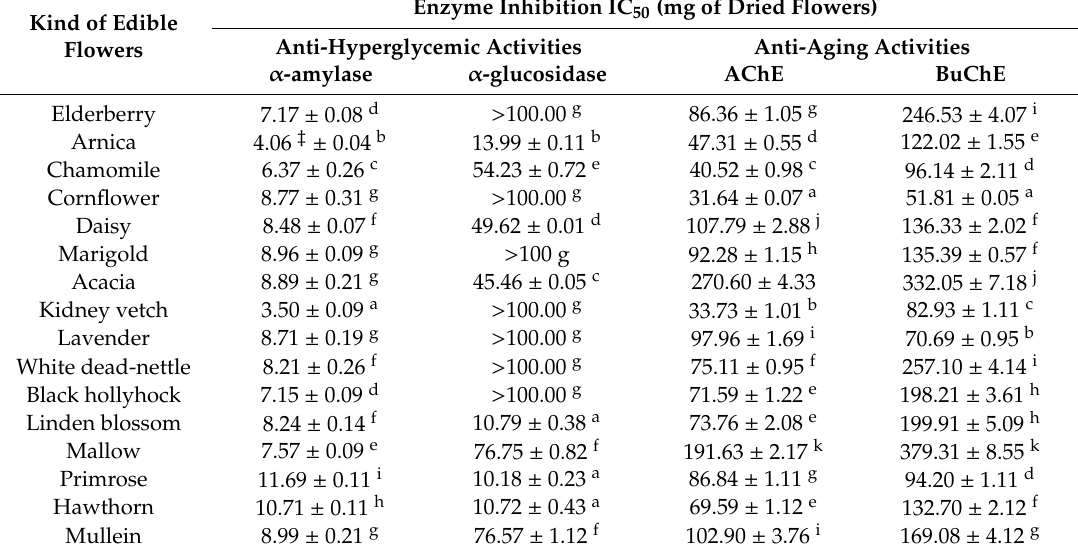
Table 3. Enzyme of α -amylase. α -glucosidase, acetylcholinesterase and butyrylcholinesterase inhibitory activities in 16 selected edible